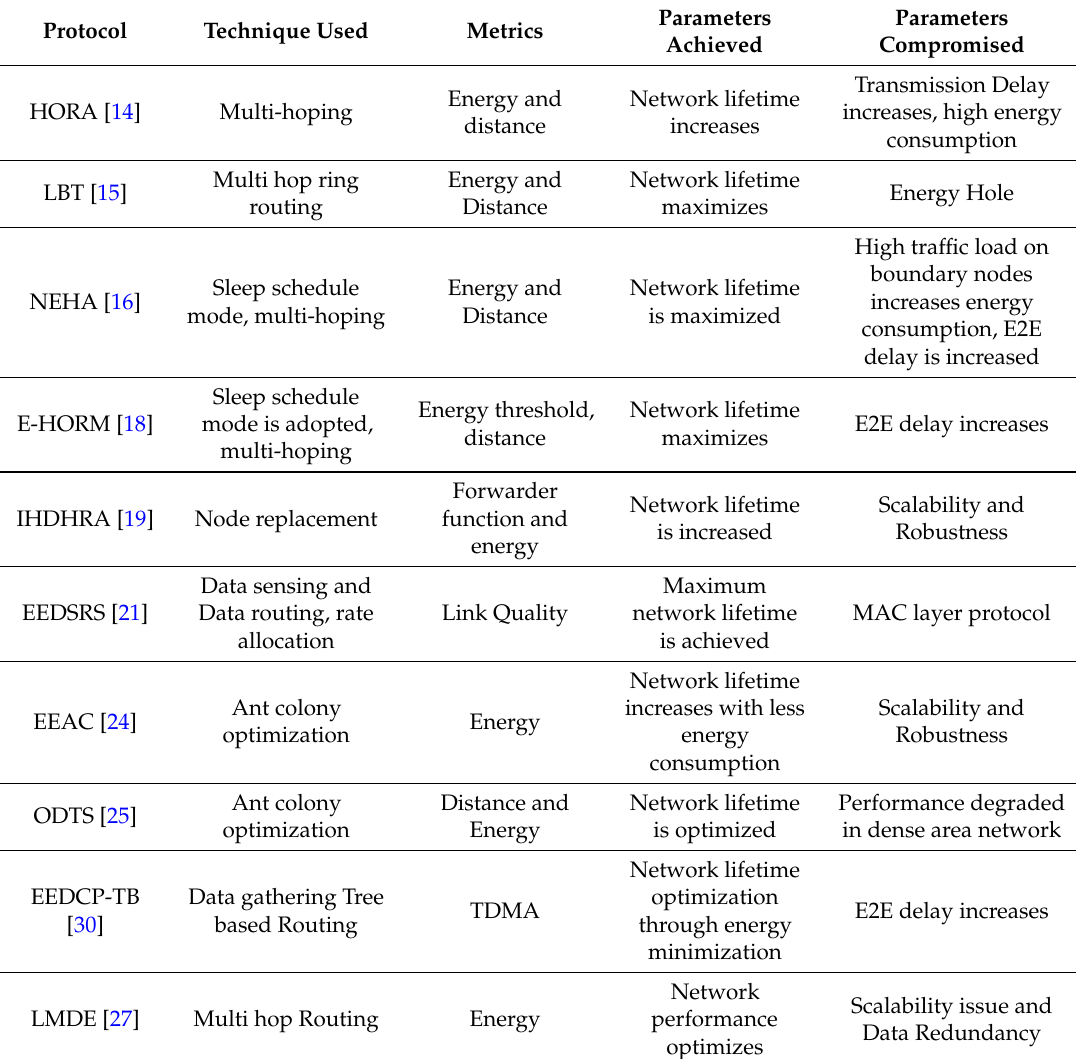
Table 1. Comparison of the State of the Art in